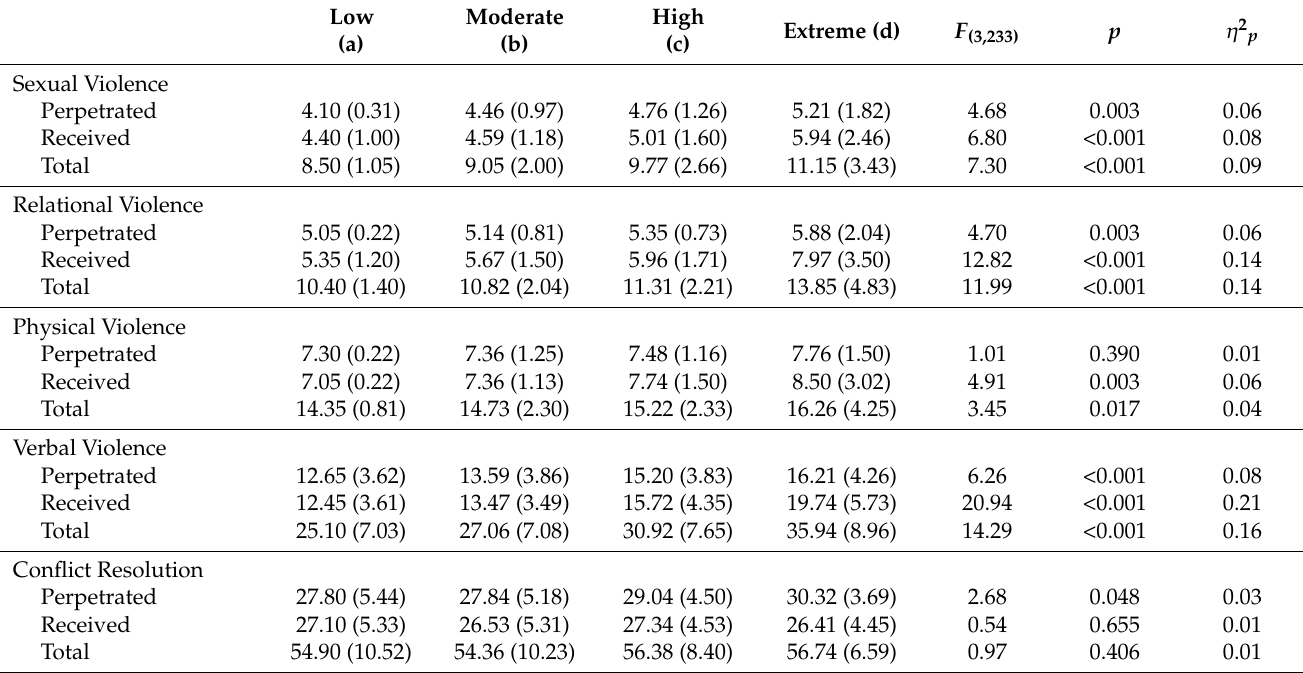
Table 4. Subscale scores on the CADRI—Conflict in Adolescent Dating Relationship Inventory according to categories of the Partner’s Emotional Dependency Scale